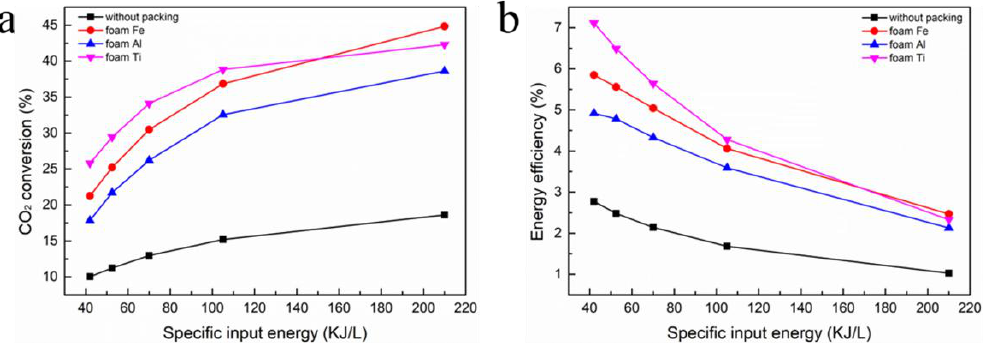
Figure 9. Effect of specific input energy of different foam metals on: ( a ) CO 2 conversion; ( b ) energy efficiency.